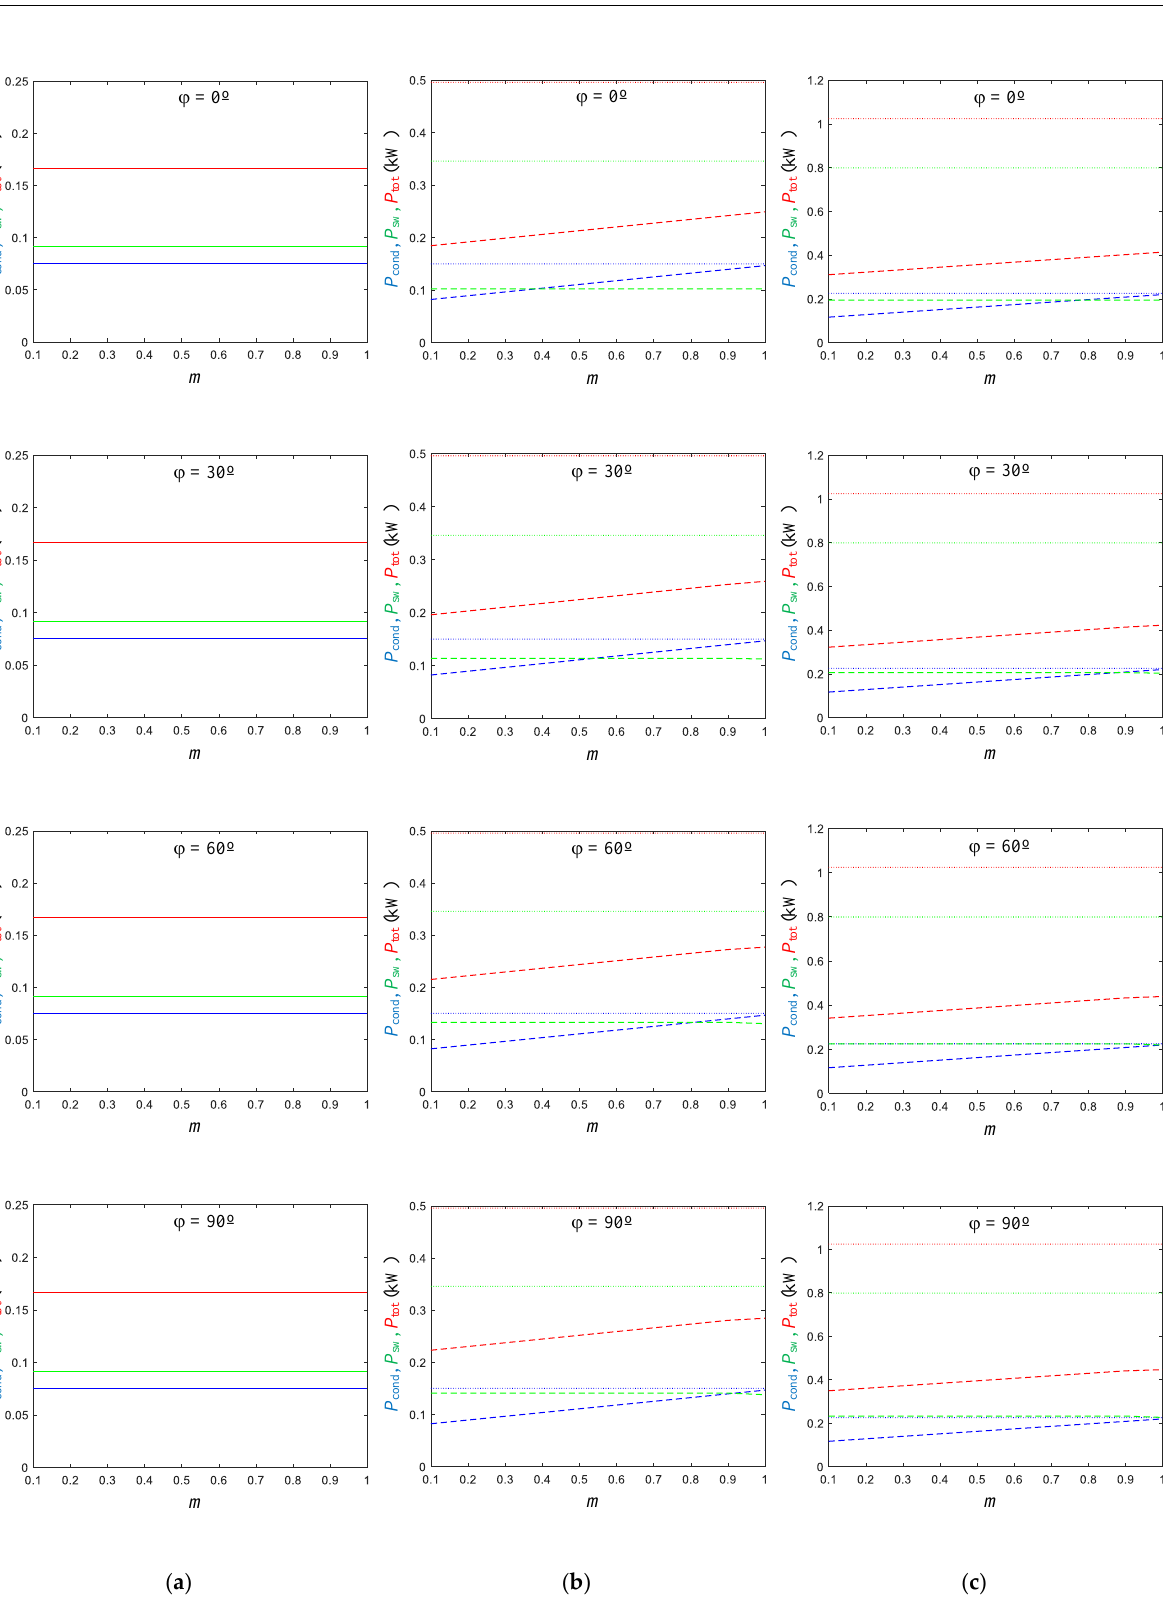
Figure 5. Average conduction P cond (blue), switching P sw (green), and total P tot (red) inverter power loss at one fourth of the nominal phase current and several motor phase current-voltage displacement angles ϕ , as a function of the modulation index. Dotted lines correspond to design A, dashed lines correspond to design B, and solid lines correspond to both designs A and B. ( a ) EV 1 . ( b ) EV 2 . ( c ) EV 3